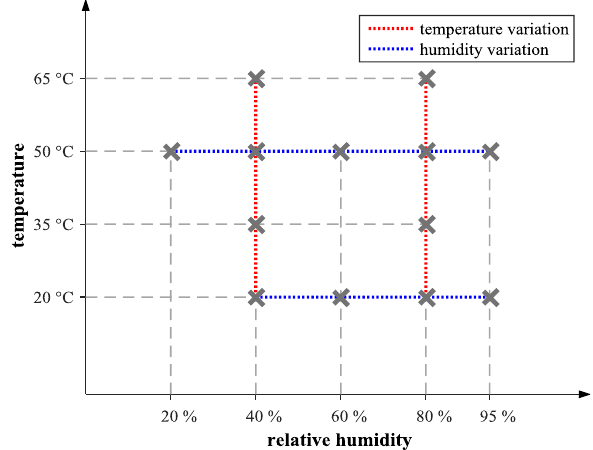
Fig. 3. Overview of the investigated climatic conditions.